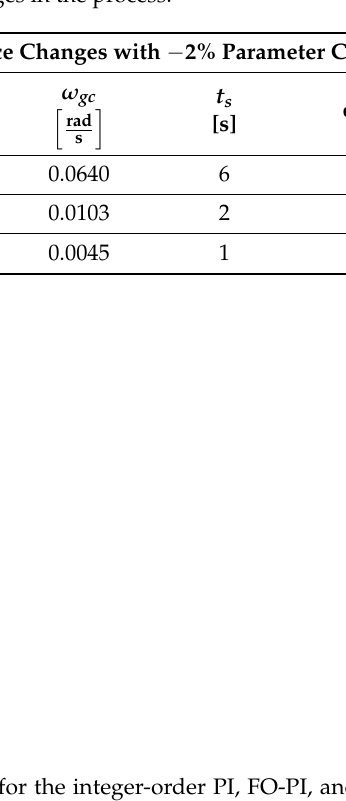
Table 5. Performance results for − 2% parameter changes in the process.